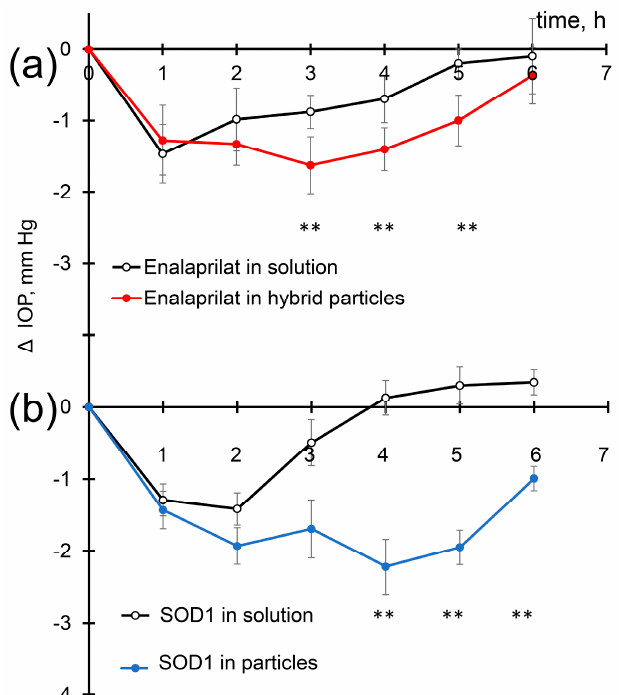
Figure 5. Intraocular pressure (IOP) decrease in normotensive rabbits after single instillations of ( a ) enalaprilat-loaded particles and enalaprilat in aqueous solution; ( b ) SOD1-loaded hybrid particles and SOD1 in aqueous solution. ** p < 0.01.